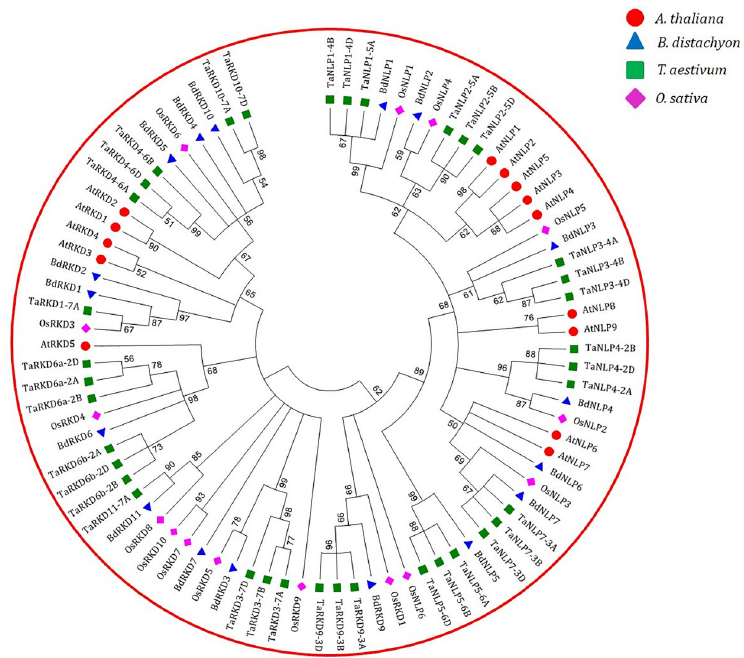
Fig 8. Phylogenetic tree constructed using proteins sequences of RKDs and NLPs belonging to four plant species ( A . thaliana , B . distachyon , O . sativa and T . aestivum ). Red, magenta, blue and green colours represent proteins sequences of RKDs and NLPs belonging to A . thaliana , O . sativa , B . distachyon and T . aestivum , respectively. The branch length represents the magnitude of genetic change.